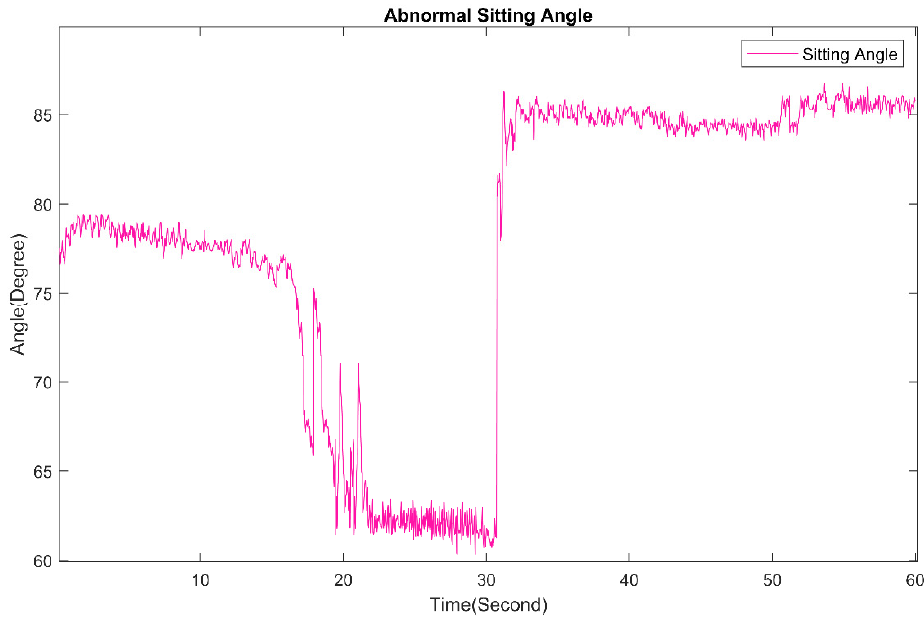
Figure 13. Plot of abnormal sitting angle.